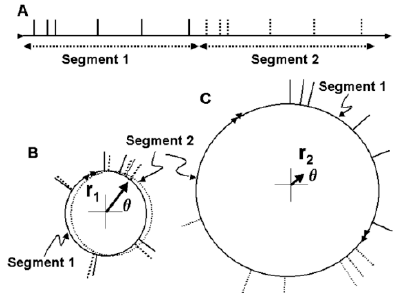
Figure 10. Schematic representation of the Schuster periodogram utilizing circular statistics. ( A ) A spike train is divided into segments; ( B ) each of the two segments is closed to form a circle, and the time of occurrence of each action potential is plotted as a unit vector on the circumference. As can be seen, the unit vectors are not distributed randomly over the circumference. A resultant vector is determined (r 1 ), which, in the situation depicted by B, will be nonzero. The magnitude of the resultant vector indicates the statistical significance of the power at the frequency corresponding to the lengths of the segments. The resultant vectors can be calculated for segments of any size, thus corresponding to a specific frequency analogous to the power at any frequency in a Fourier transform. The angle, θ indicates the phase of the periodic or oscillatory activity.